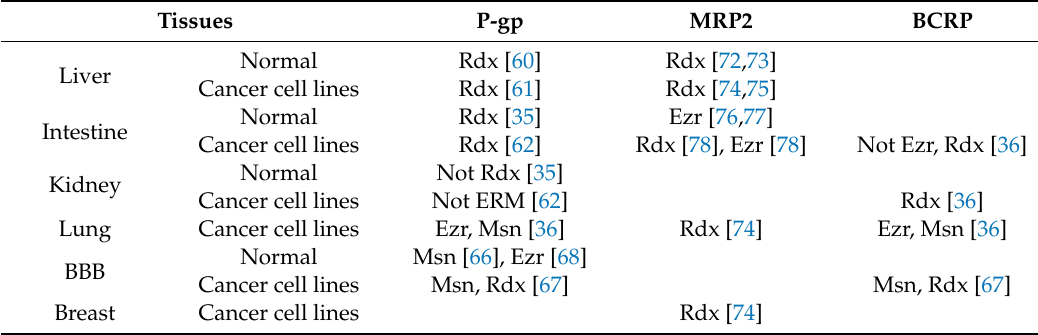
Table 2. E ffl ux transporters and their presumed sca ff old